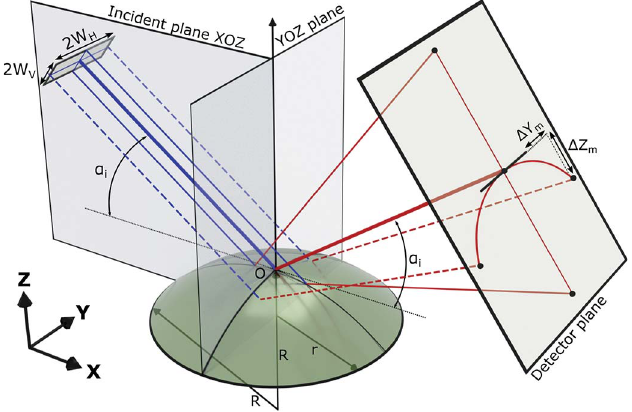
Figure 1 Scheme of the incidence and reflected X-ray beam on a spherical surface with a coordinate system selection. Solid blue and solid red rays represent the primary and reflected rays propagating in the incident plane XOZ , while dashed blue and red rays are in the orthogonal plane. A curved surface is considered as a cut from a sphere of radius R having base radius r . (cid:2) Y m and (cid:2) Z m indicate the offsets of the ray reflected on the surface curved in the coronal plane in comparison with the reflection on the flat